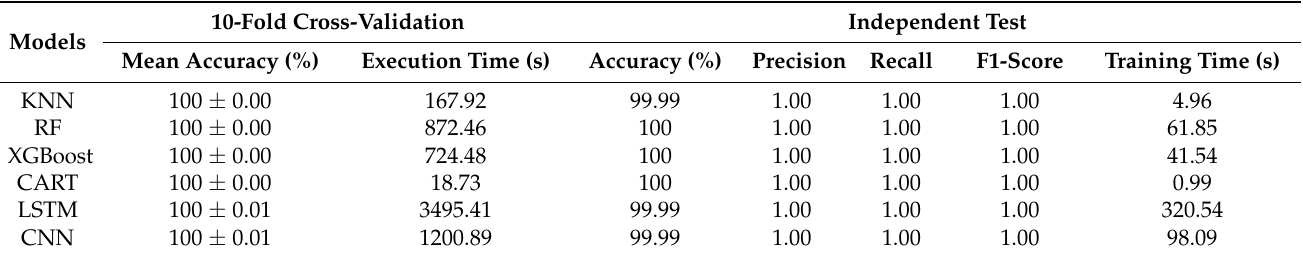
Table 6. Performance metrics for anomaly detection for 10-fold cross-validation with standard deviation and independent test. 10-Fold Models